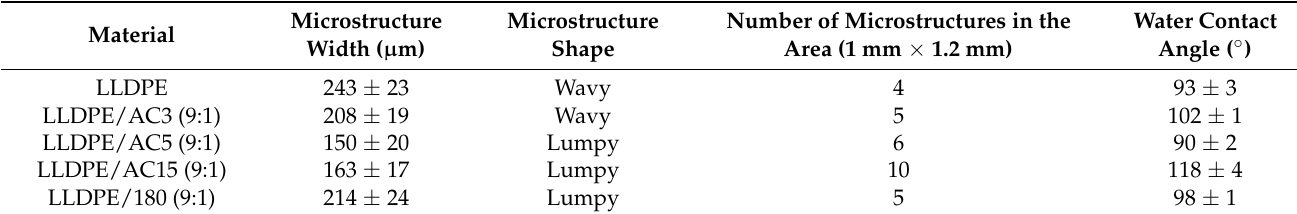
Table 1. Surface characteristics of measured samples from different